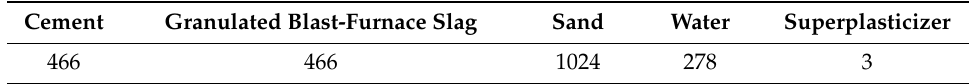
Table 2. Mixture composition of binder (unit, kg / m 3 ).